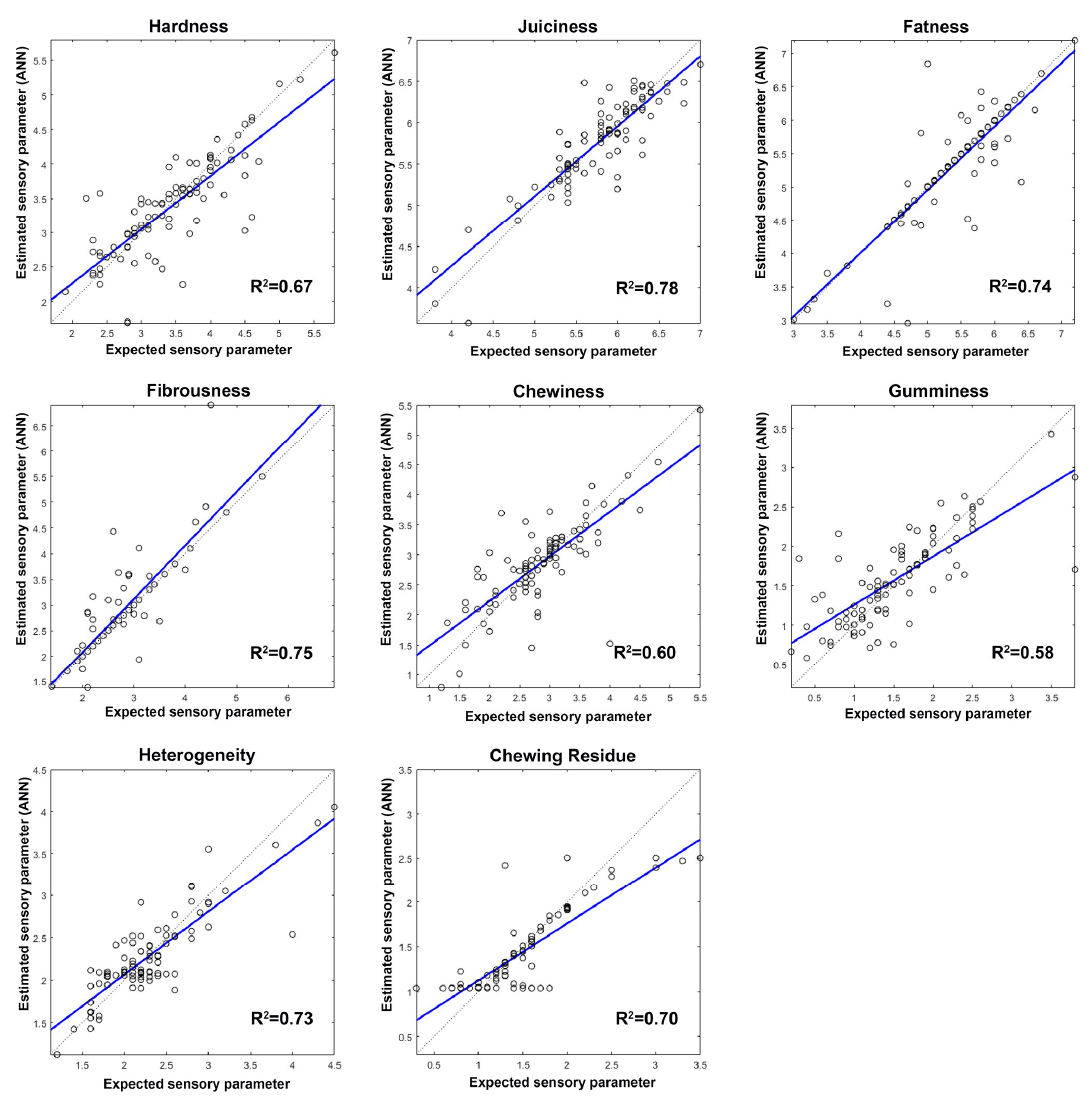
Figure 5. Comparison of the reference values (target) with the values predicted by ANNs for texture parameters and R 2.